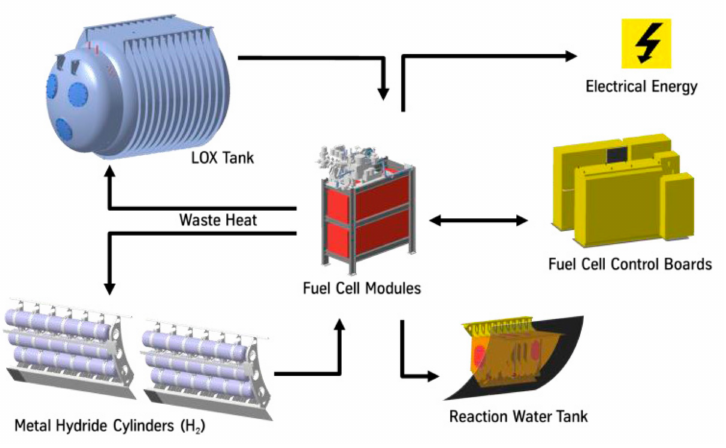
Figure 7. PEMFC Configuration on Class 212 A and 214 Submarines